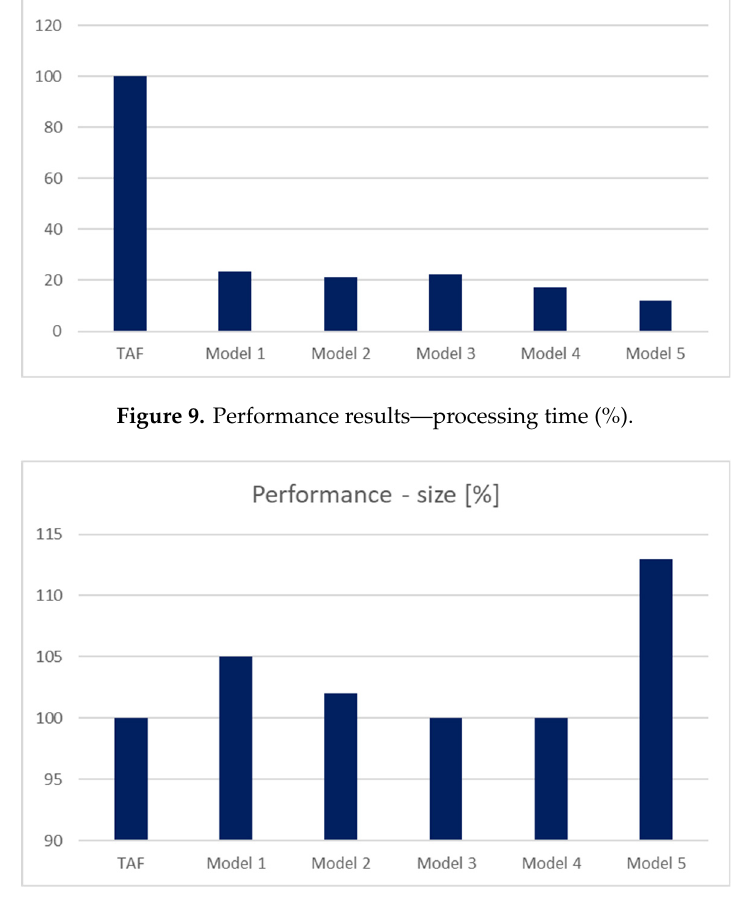
Figure 10. Performance results – structure size demands (%).